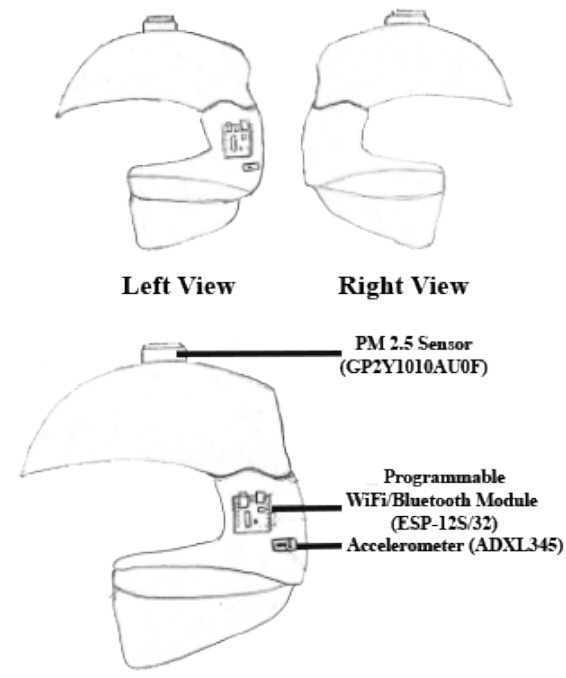
Figure 4. SmartPPM helmet schematic, showing the fitting scheme of the sensors on and inside the helmet. Fig. 4, shows schematic of the helmet and the fitting location of the sensors inside and over it. We have mounted the PM 2.5 sensor on the top of the